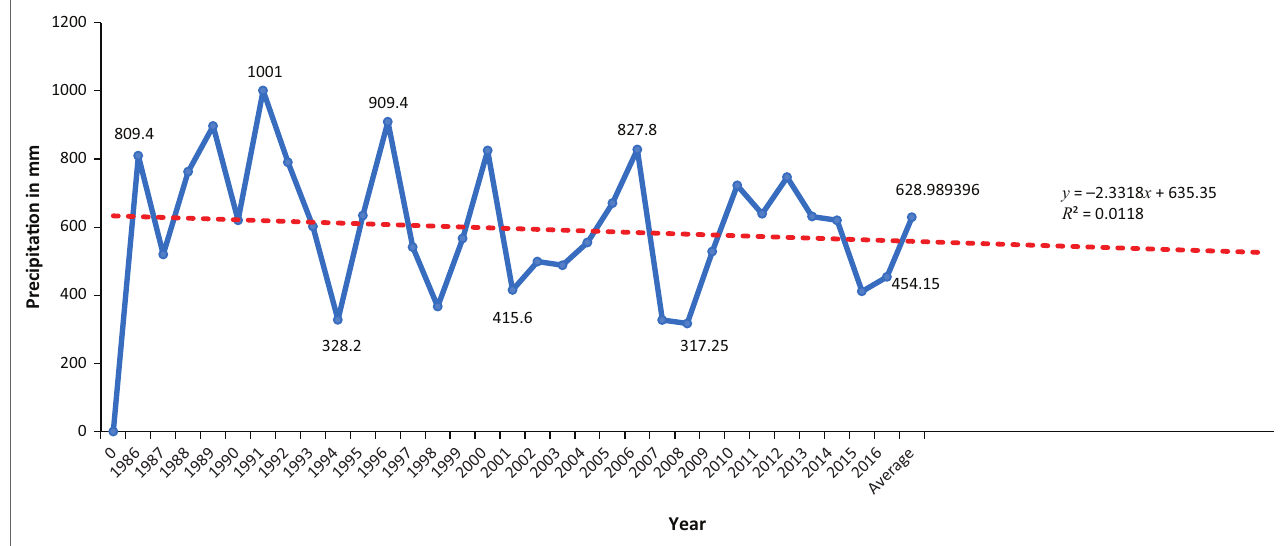
FIGURE 1: Phuthaditjhaba mean annual precipitation pattern for period 1986–2016 (in mm) and projection up to